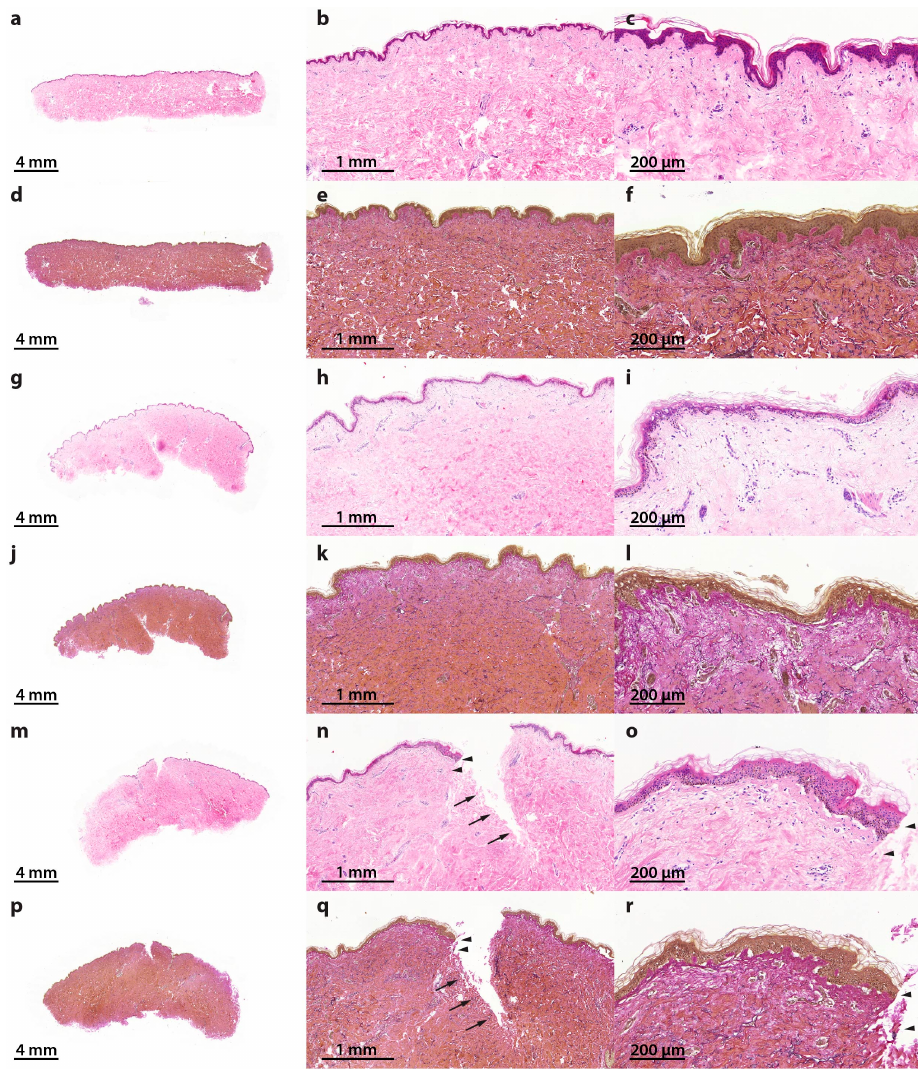
Figure 2. Hematoxylin–eosin (HE) and Elastica-van-Gieson (EvG) staining of patient 1 show vital skin structure at all times of investigation without necrosis or inflammation: reference samples, 0 day (HE ( a – c ); EvG ( d – f ); 0.5× ( a , d ), 3.5× ( b , e ) and 11.5× magnification ( c , f )), 10 days non-wounded (HE ( g – i ); EvG ( j – l ); 0.5× ( g , j ), 3.5× ( h , k ) and 11.5× magnification ( i , l )) and 10 days wounded (HE ( m – o ); EvG ( p – r ); 0.5× ( m , p ), 3.5× ( n , q ) and 11.5× magnification ( o , r )). Wound edges are identified with arrows and arrowheads. Arrowheads show wound edge area at 11.5× magnification, in accordance with areas at 3.5× magnification.